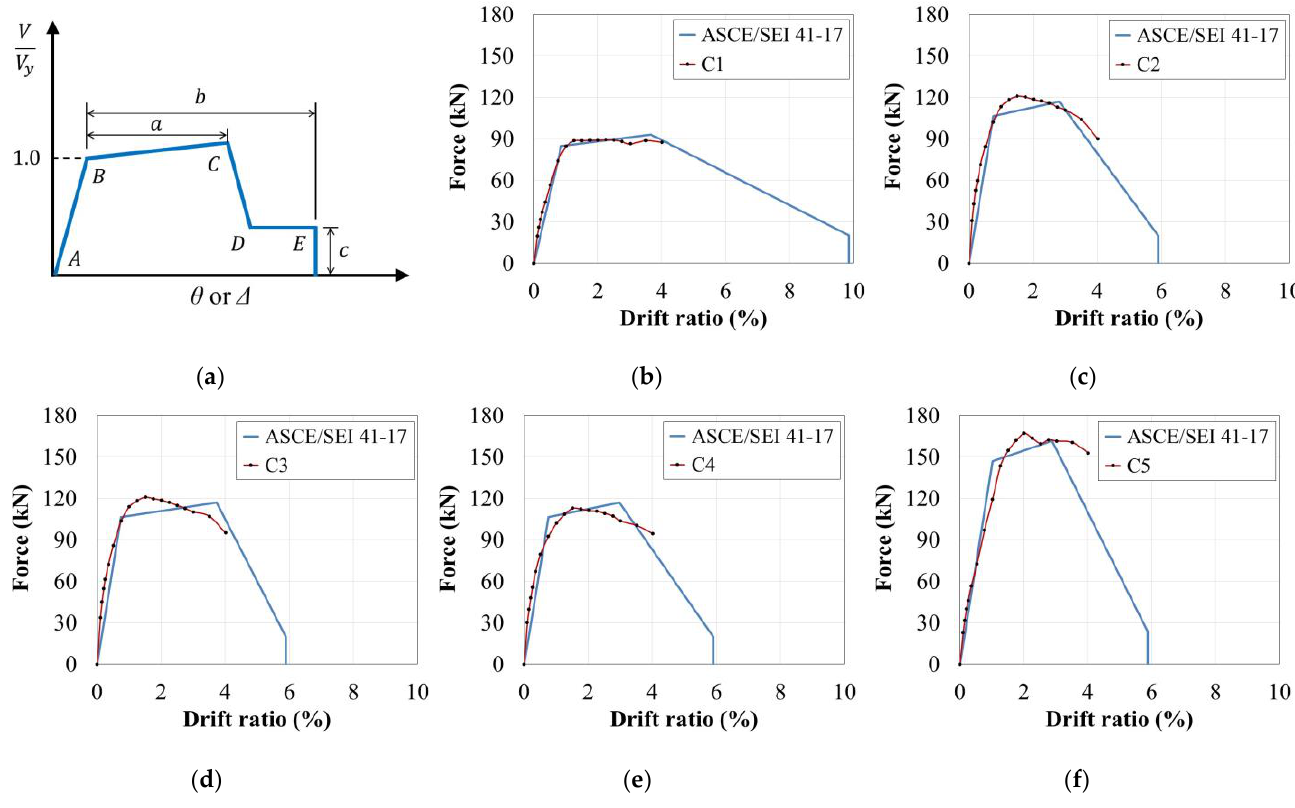
Figure 12. Comparison of backbone curves obtained from ASCE/SEI 41-17 and the test results: ( a ) Generalized component force – deformation relations; ( b ) C1; ( c ) C2; ( d ) C3; ( e ) C4; ( f ) C5. Table 4. Effective rigidity values (ASCE/SEI 41-17 [37]).